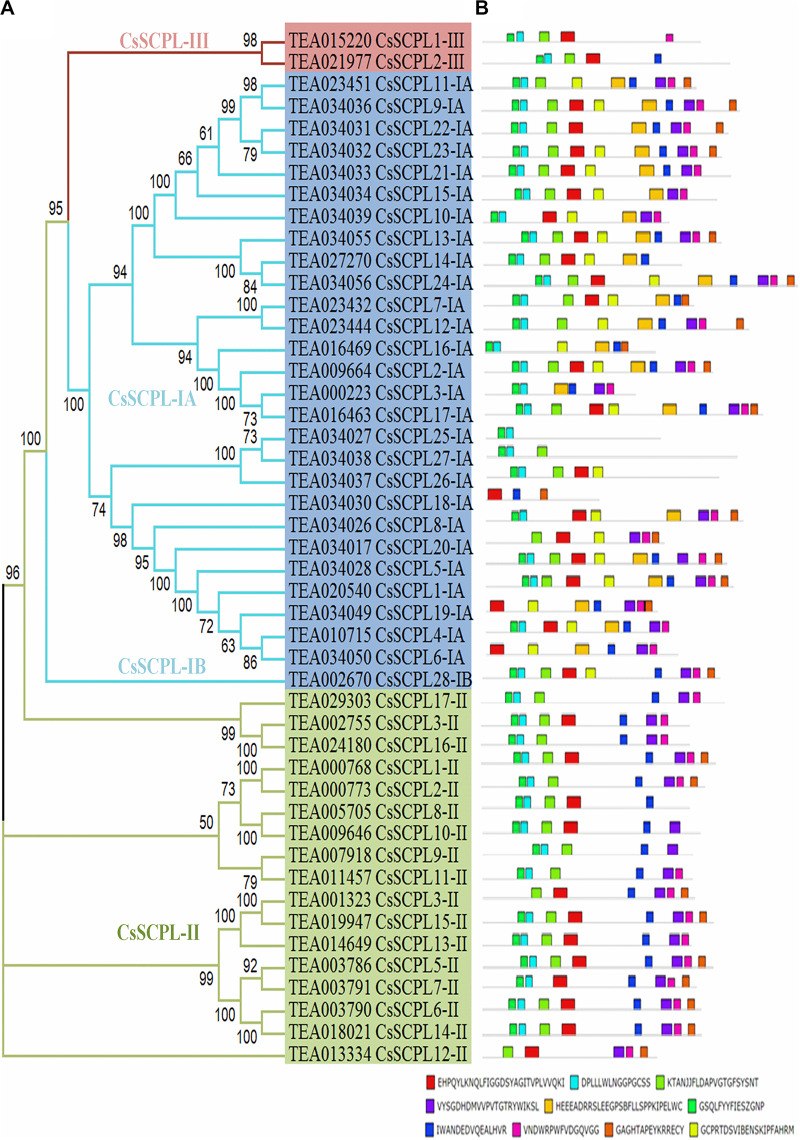
Phylogenetic analyses and conserved motif analysis of tea CsSCPL genes. (A) The phylogenetic tree of CsSCPLs genes was constructed through MEGA 6.0 using the Neighbor-Joining (NJ) method. Bootstrap values in percentage (1,000 replicates) are indicated on the nodes. The subclades are identified with different colors: SCPL-I (blue), SCPL-II (green), and SCPL-III (maroon). (B) The identified motifs of ScSCPL proteins are shown as colored boxes. The CsSCPL proteins are listed according to their phylogenetic relationships.